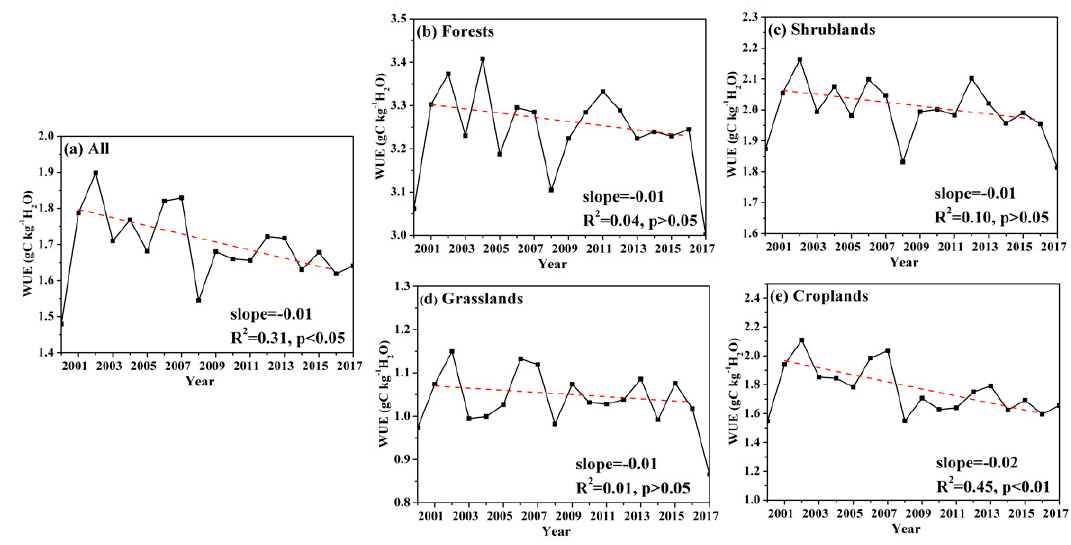
Figure 4. The variations and trends of spatially averaged annual WUE in Southwest China over the period 2000–2017: ( a ) all vegetated grid cells; ( b ) forests; ( c ) shrublands; ( d ) grasslands; and ( e ) croplands. The dashed, red lines are the trend lines over the period 2001–2016, and the start (2000) and end (2017) years of the study period (2000–2017) are excluded to remove the effects of the start and the end years. The trend lines over the period 2000–2017 are not statistically significant except for croplands and are not plotted.